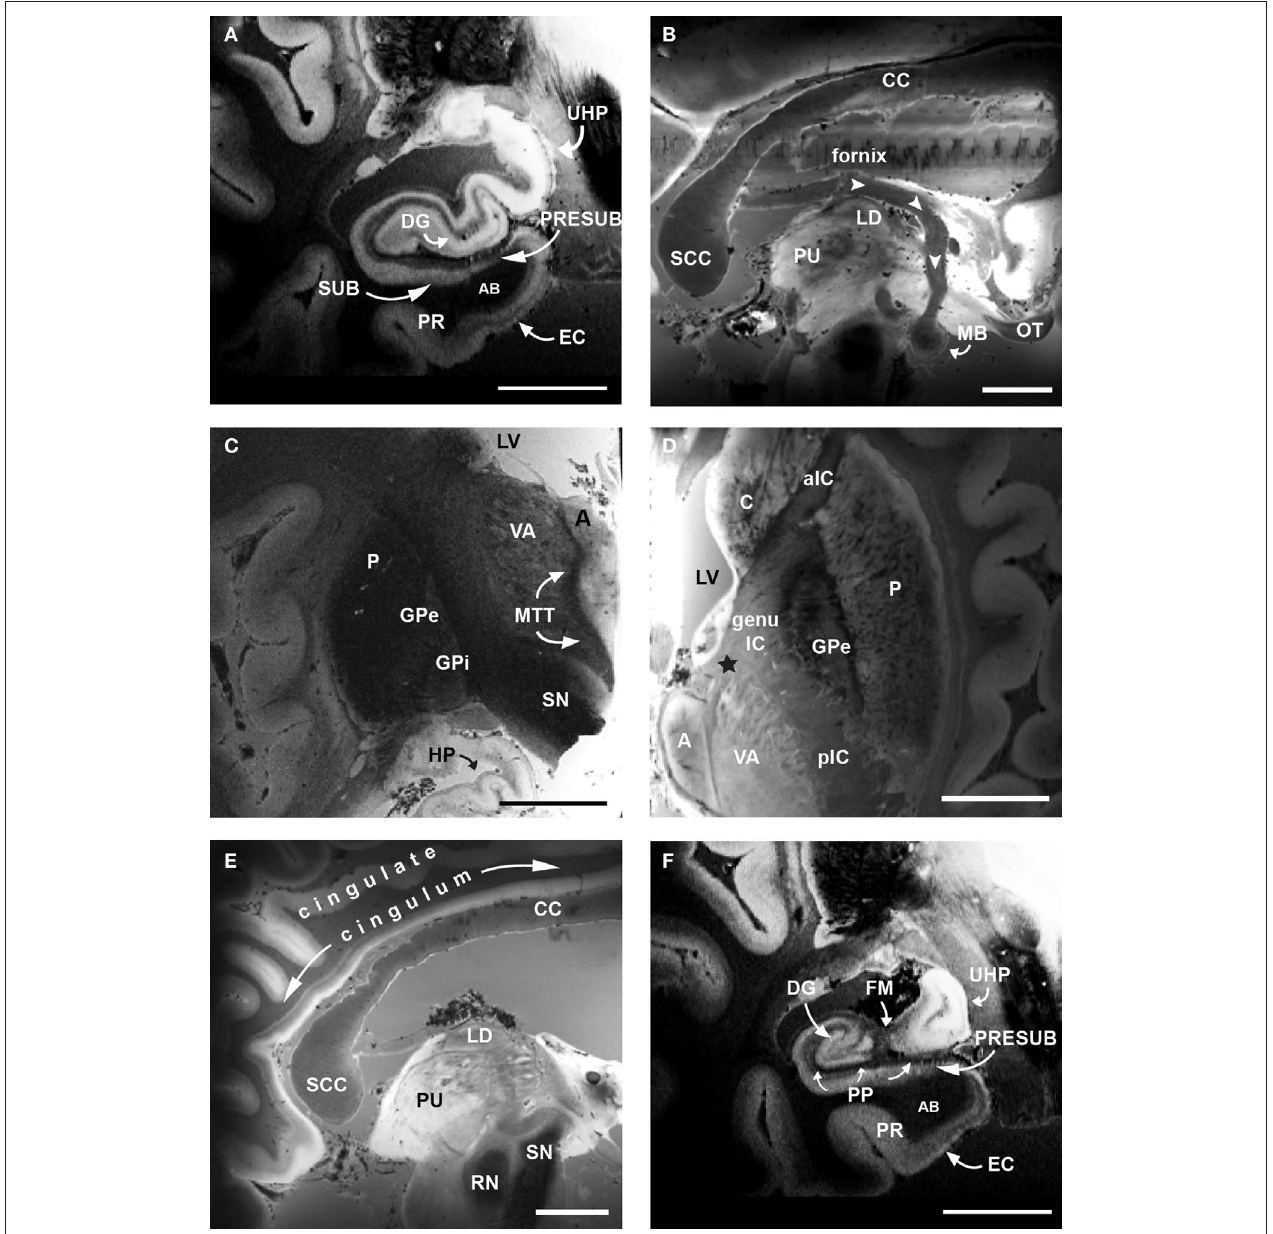
angular bundle; aIC, anterior limb of the internal capsule; C, caudate; CC, corpus callosum; DG, dentate gyrus; EC, entorhinal cortex; FM, fimbria; genu IC, genu of the internal capsule; GPe, external globus pallidus; GPi, internal globus pallidus; HP, hippocampus; LD, lateral dorsal nuclues of the thalamus; LV, lateral ventricle; MB, mammillary bodies; MTT, mammillothalamic tract; OT, optic tract; P, putamen; pIC, posterior limb of the internal capsule; PP, perforant pathway; PR, perirhinal cortex; PRESUB, presubiculum; PU, pulvinar; RN, red nuclues; SCC, splenium of the corpus callosum; SN, substantia nigra; SUB, subiculum; UHP, uncal hippocampus; VA, ventral anterior nucleus of the